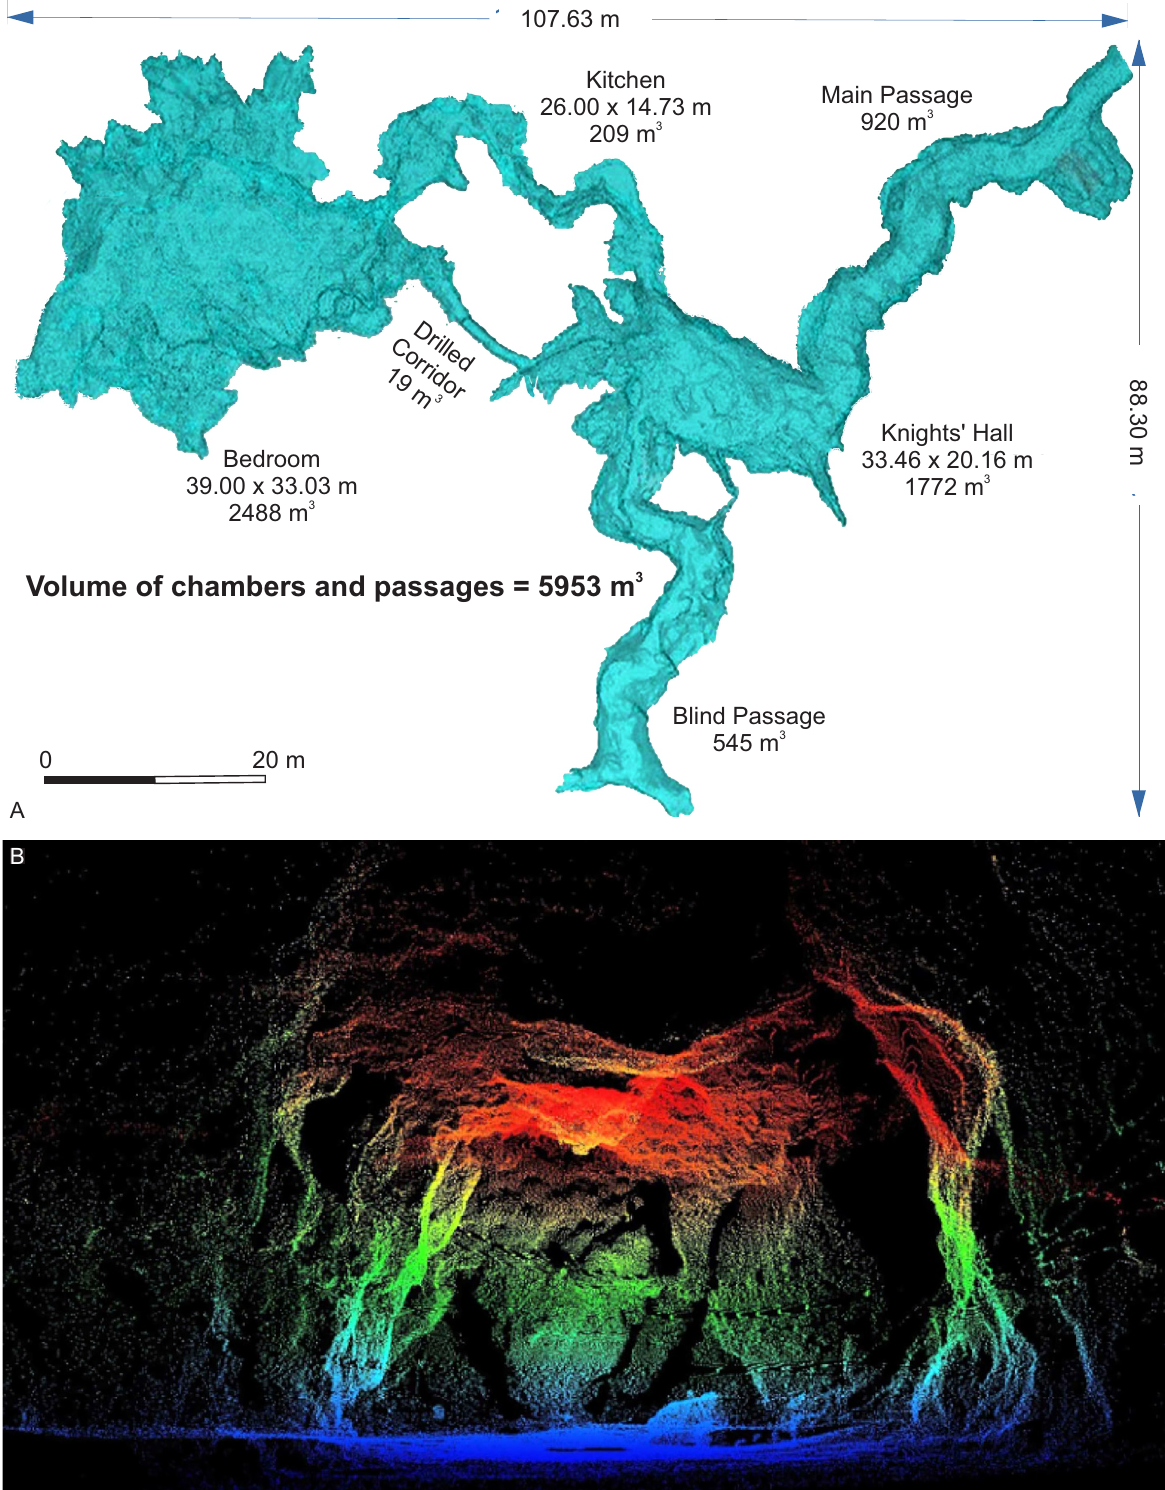
Fig. 3. The Łokietek's Cave. A – Model 3D and dimensions of chambers and passages; B – Isometric projection of a section of the Knights’ Hall; projection composed of 357 terrestrial laser scanning (TlS) images; (Curtesy